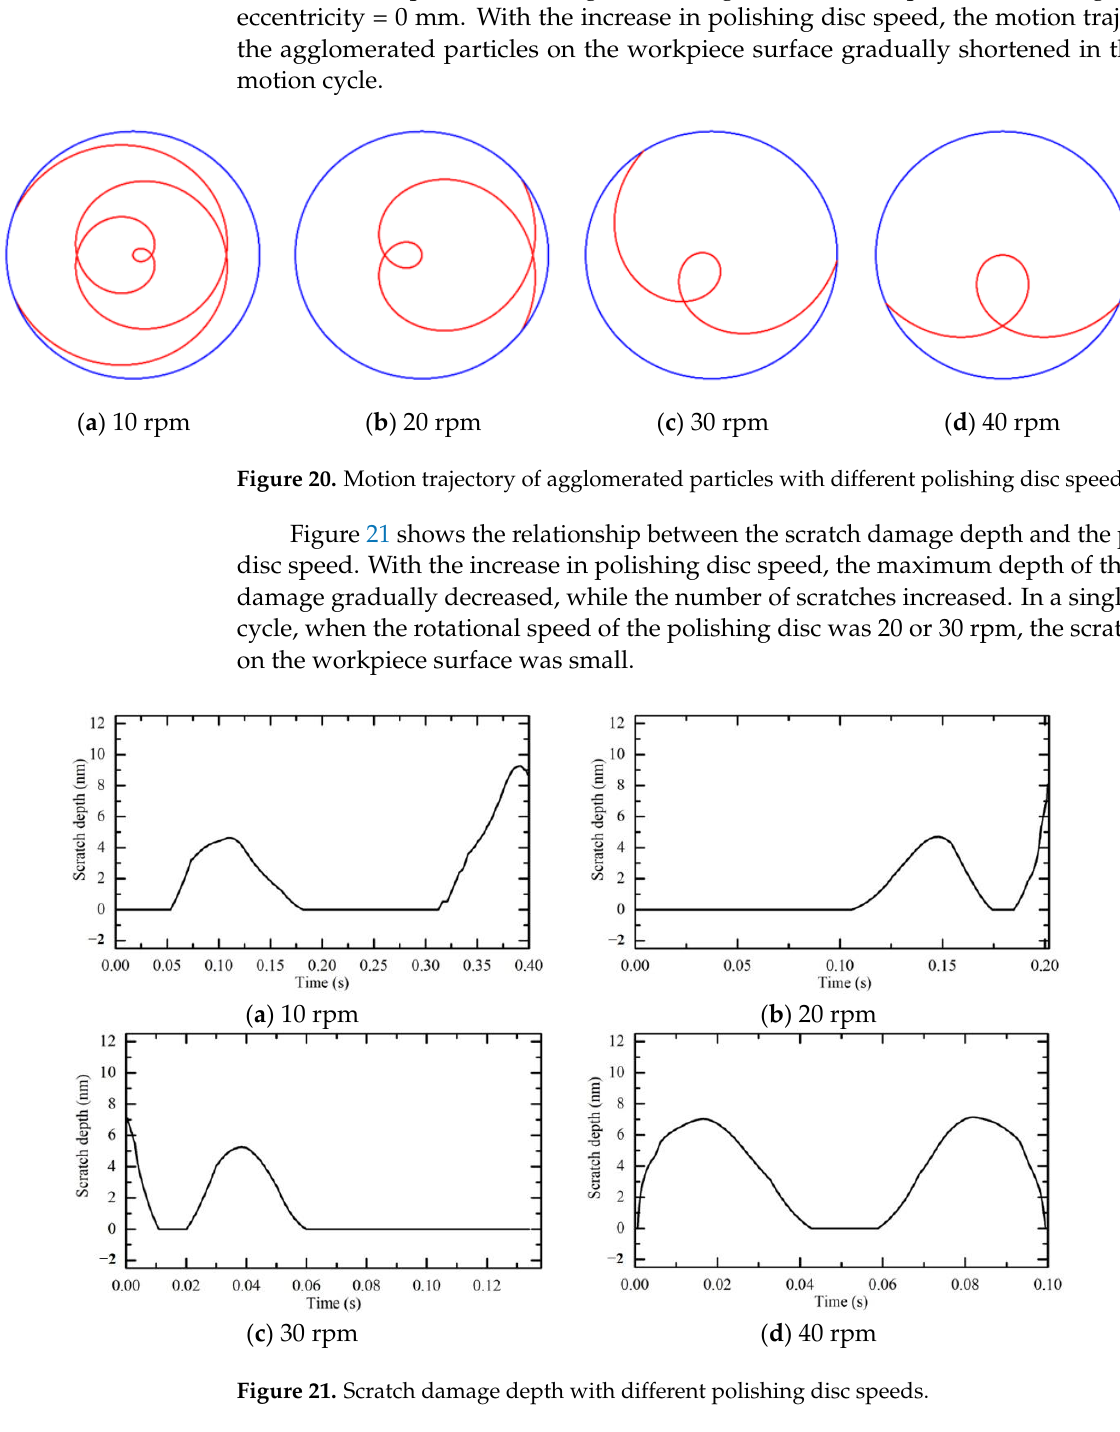
Figure 19. Scratch damage morphology on the workpiece surface with different workpiece speeds.